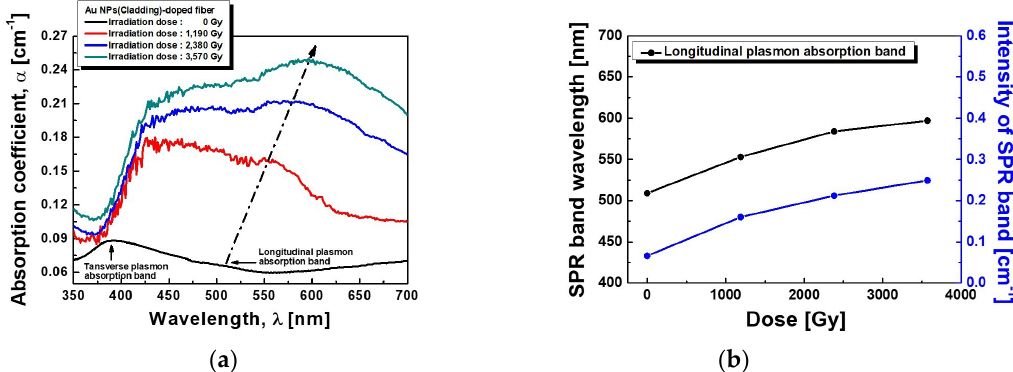
Figure 3. ( a ) Absorption spectra and ( b ) peak wavelength and intensity of the SPR band of the optical fiber incorporated with Au NPs before and after the γ -ray irradiation at the total dose of 1190 Gy, 2380 Gy, and 3570 Gy.